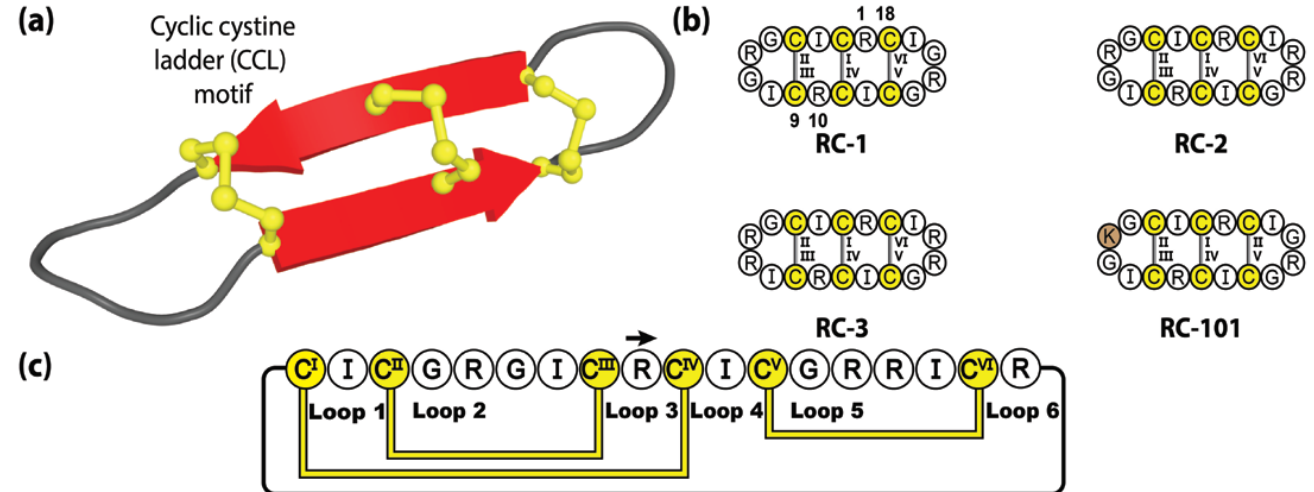
Figure 6. Structure and sequence of the genetically encoded, but untranslated, retrocyclin family. ( a ) Three-dimensional structure of retrocyclin RC-2. ( b ) Peptide sequences of three natively encoded retrocyclins and the engineered retrocyclin variant RC-101. ( c ) Amino acid sequence, disulfide bond connectivity and loop nomenclature of retrocyclin RC-2. Cysteine residues are numbered and highlighted in yellow, with the non-native residue depicted by brown shading.